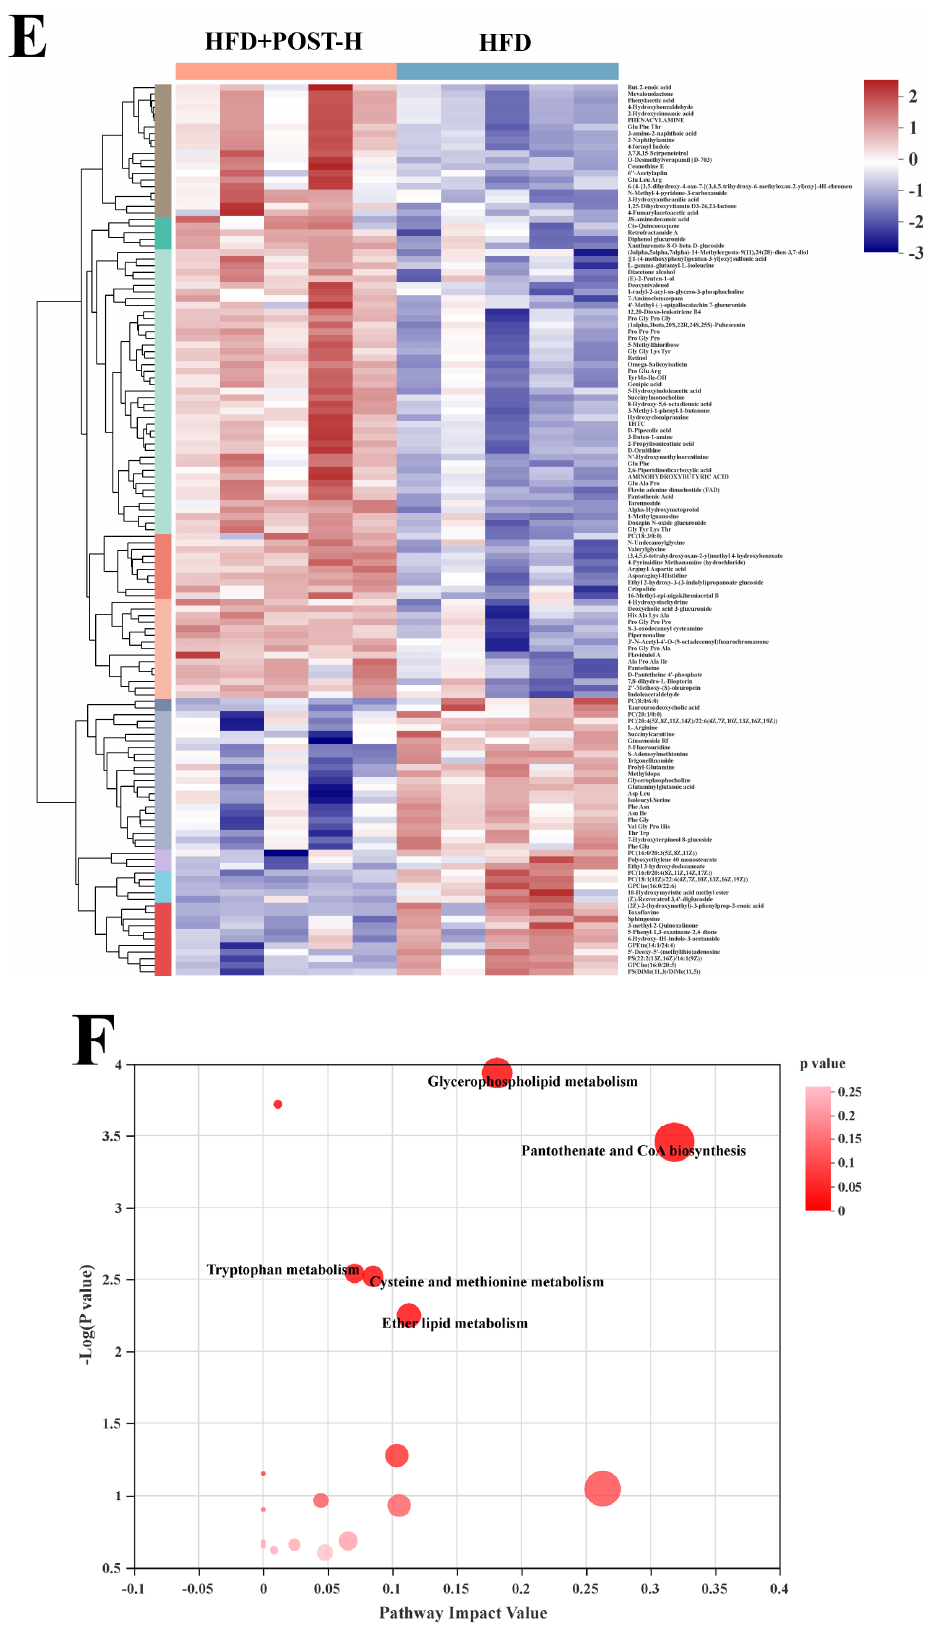
Figure 7. POST regulates hepatic metabolism (ESI+). ( A ) PCA score of the NFD, HFD and HFD +